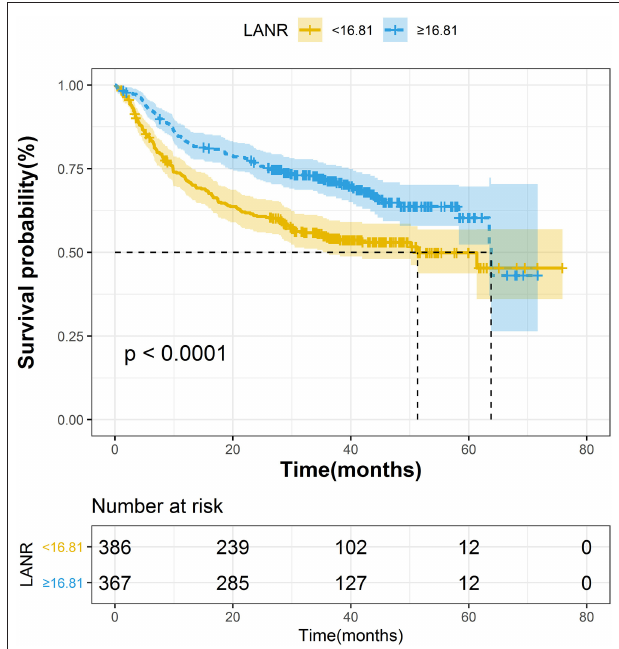
FIGURE 2 | The Kaplan–Meier curves for progression-free survival of colorectal cancer patients based on LANR.